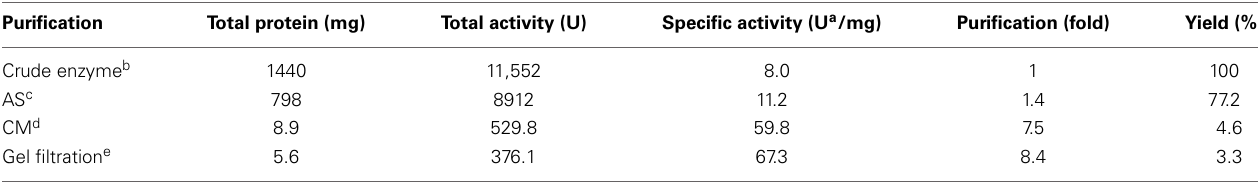
Table 1 | Summary of purification of AkEG21.